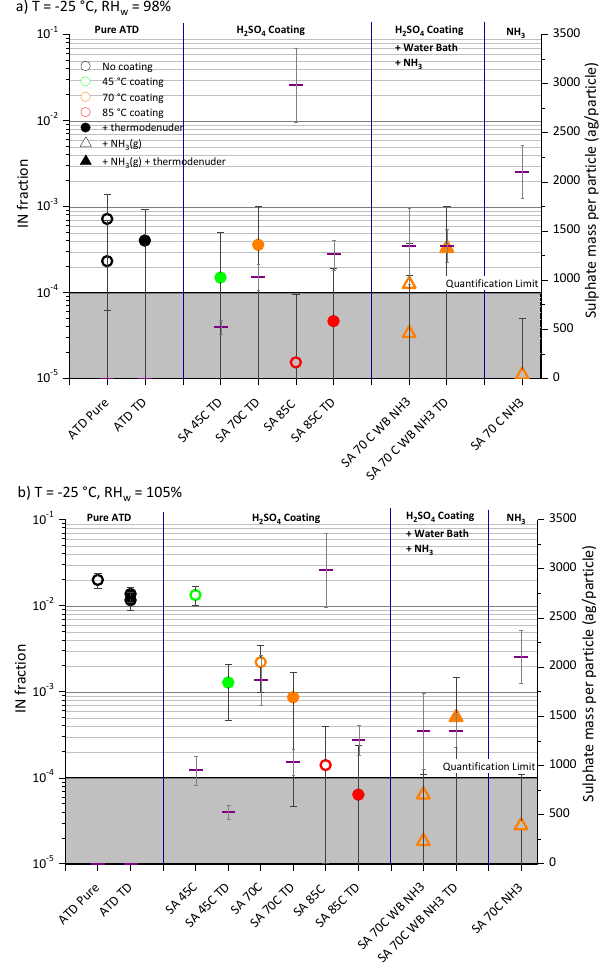
Figure 5 . Fraction of 300 nm ATD particles that nucleated ice at -25 °C, as in Fig. 4. 3